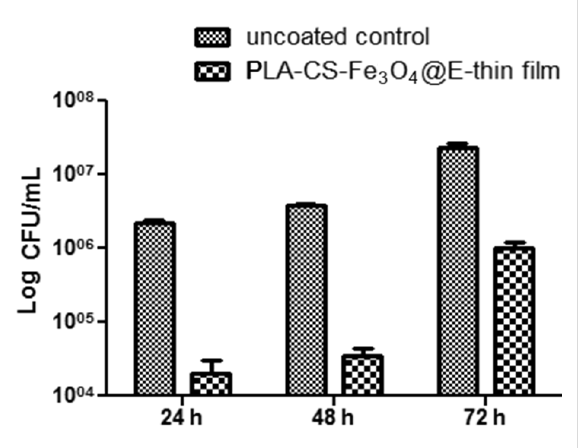
Figure 6: Human endothelial cells (EAhy926 cell line) after five days of growth on (a) control surface and (b) MAPLE coated surfaces.